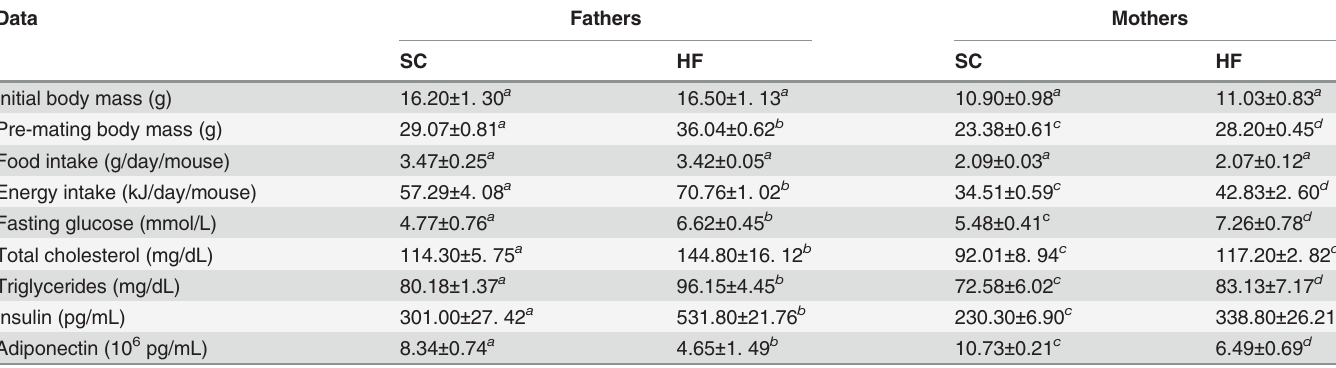
Table 3. Data of fathers and mothers fed standard chow (SC) and high-fat (HF) diet.